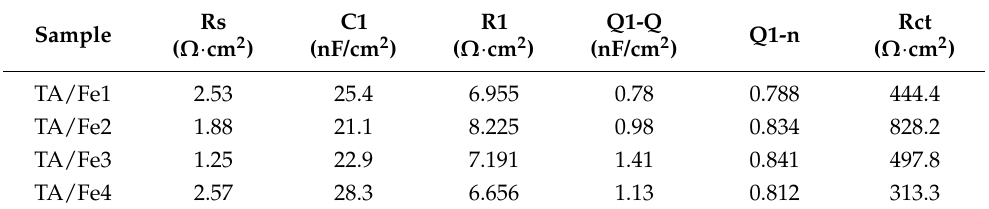
Table 4. Electrochemical impedance data of as-prepared aerogel catalysts.